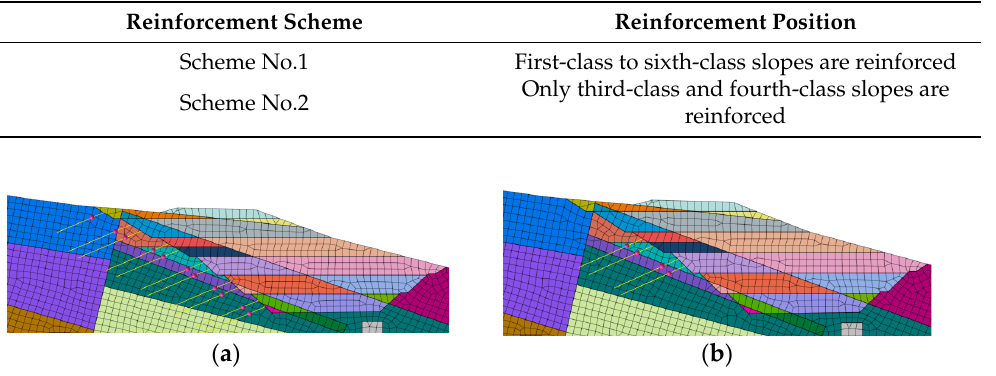
Figure 10. Slope reinforcement scheme. ( a ) Scheme No.1; ( b ) Scheme No.2.